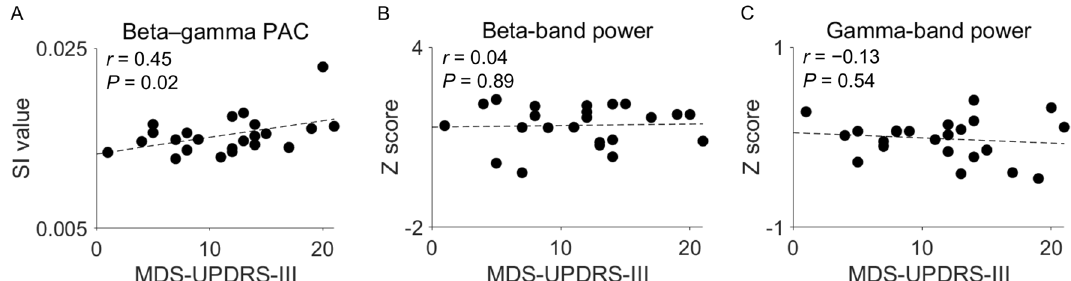
Figure 5. Correlations of disease symptoms with beta–gamma phase–amplitude coupling (PAC) and with beta- band or gamma-band power in the sensorimotor cortex. ( A ) The averaged synchronization index (SI) values for the sensorimotor cortex, in which significant PAC is present, were plotted against the sum of the MDS-UPDRS- III scores for akinesia. ( B , C ) The averaged Z scores of beta-band power ( B ) and gamma-band power ( C ) in